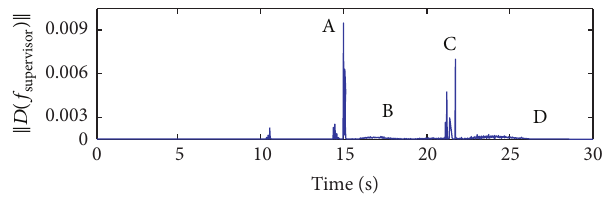
)‖ along the single mission supervisor